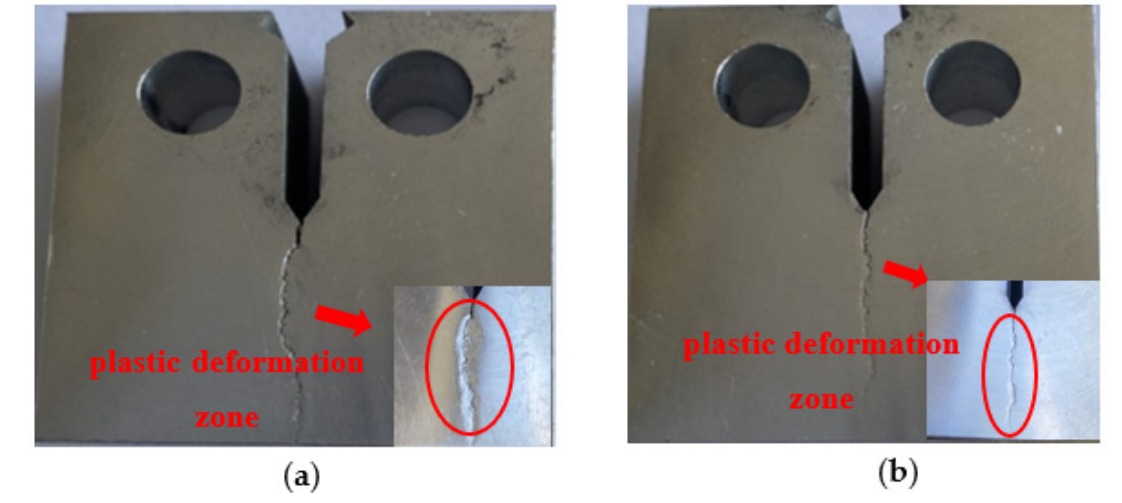
plastic deformation zone with large grain size was large, which affected the fracture mode at the crack tip.